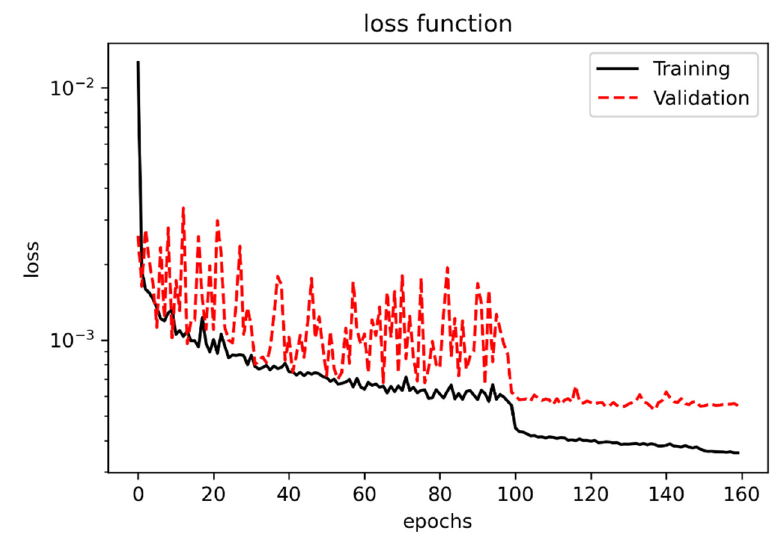
Figure 8. Transition of cost function (Reverse Huber) between the prediction and true value.